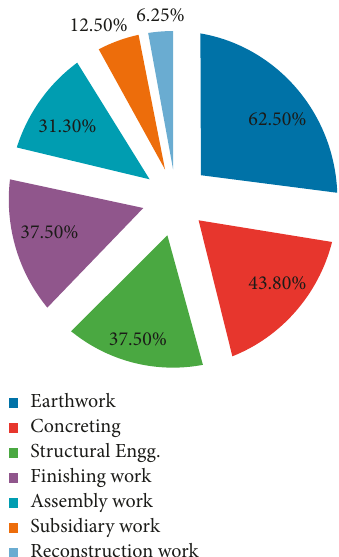
Figure 10: Percentage utilization of automation in different fields of construction